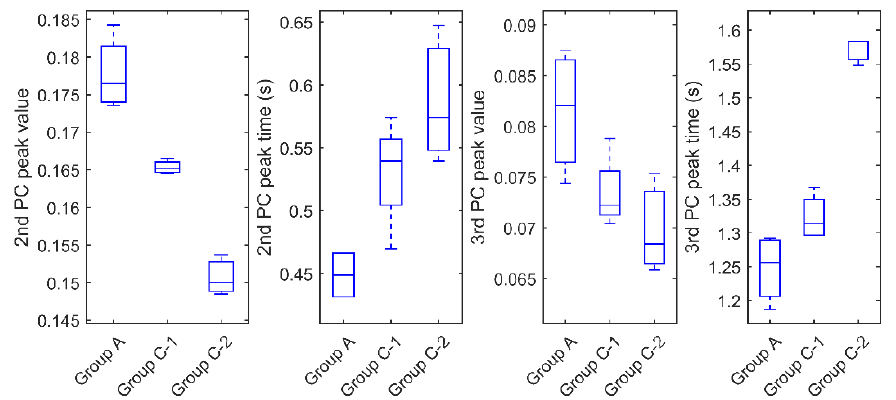
Figure 13. Feature results of the 2nd verification comparison; ( a ) the 2nd principal component profiles; ( b ) the 3rd principal component profiles.